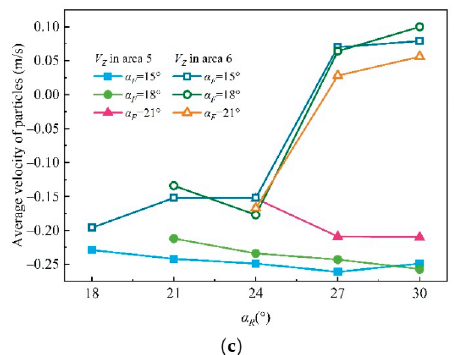
Figure 17. The velocity in three-direction of particles in the envelope zone under different helix angle matching. ( a ) X - direction; ( b ) Y -direction; ( c ) Z -direction.